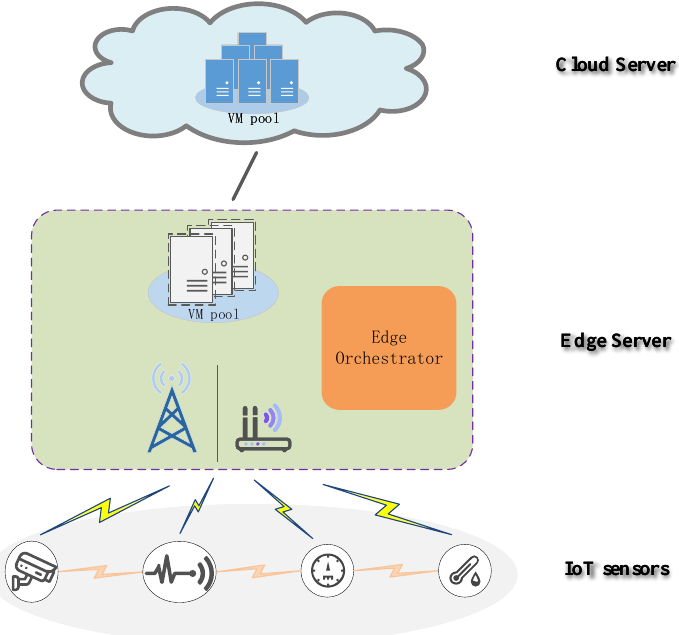
Figure 1. Cloud-assisted edge computing framework with collaborative